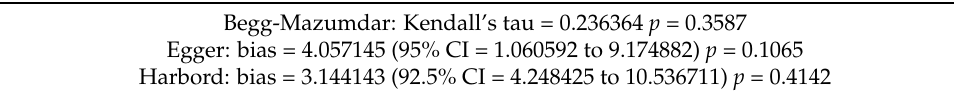
Table 2. Tests of publication bias.